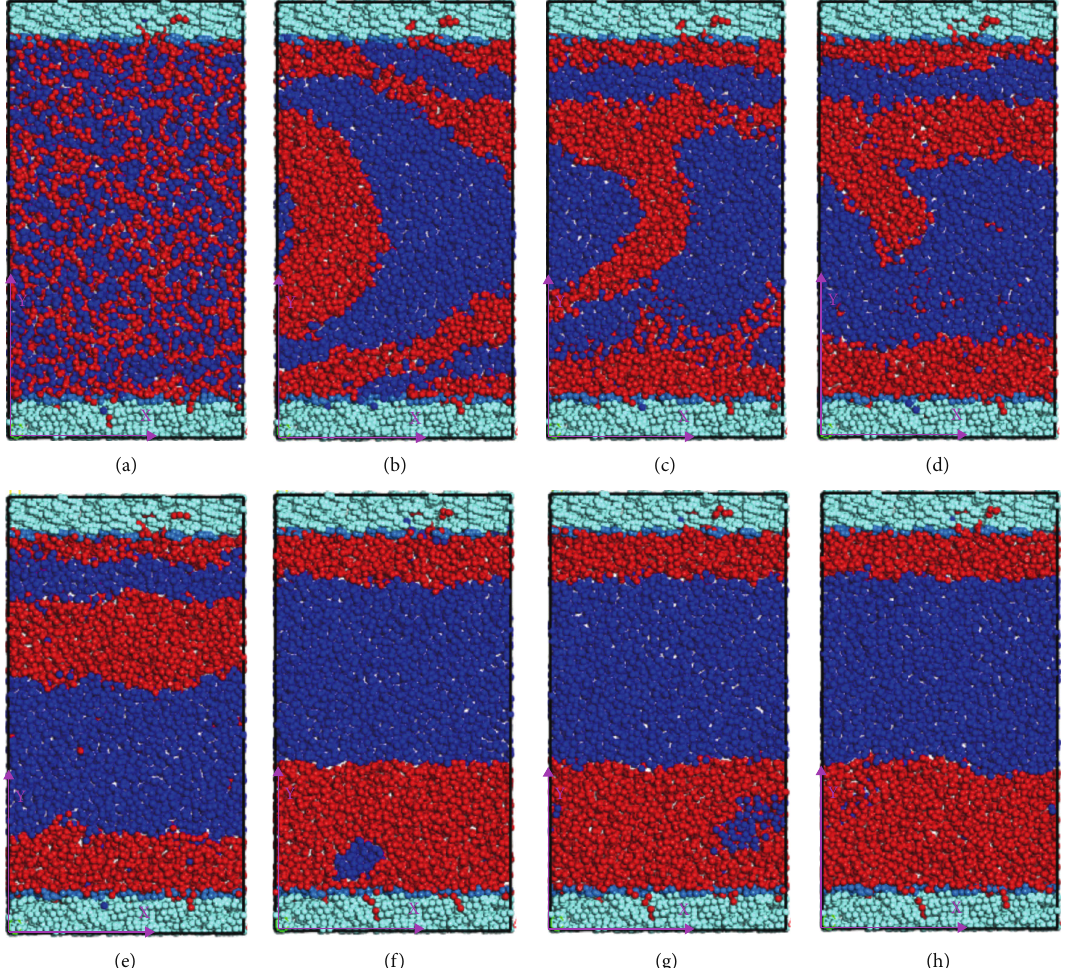
– e) model 15 and steps 5, 9, 17, and 30; (f – h) model W − H : (a) model 14 and step 24; (b